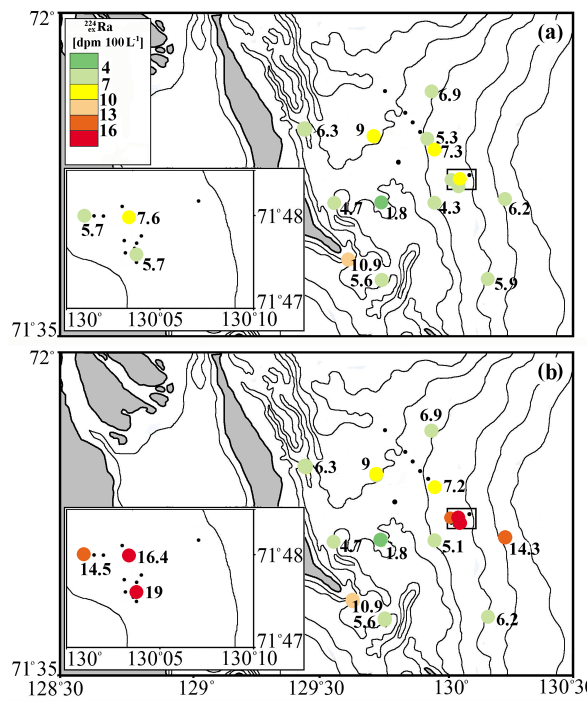
Figure 8. Winter distributions of ex 224 Ra in surface (a) and bot- tom (b) water. At the shallow stations one value is shown for both